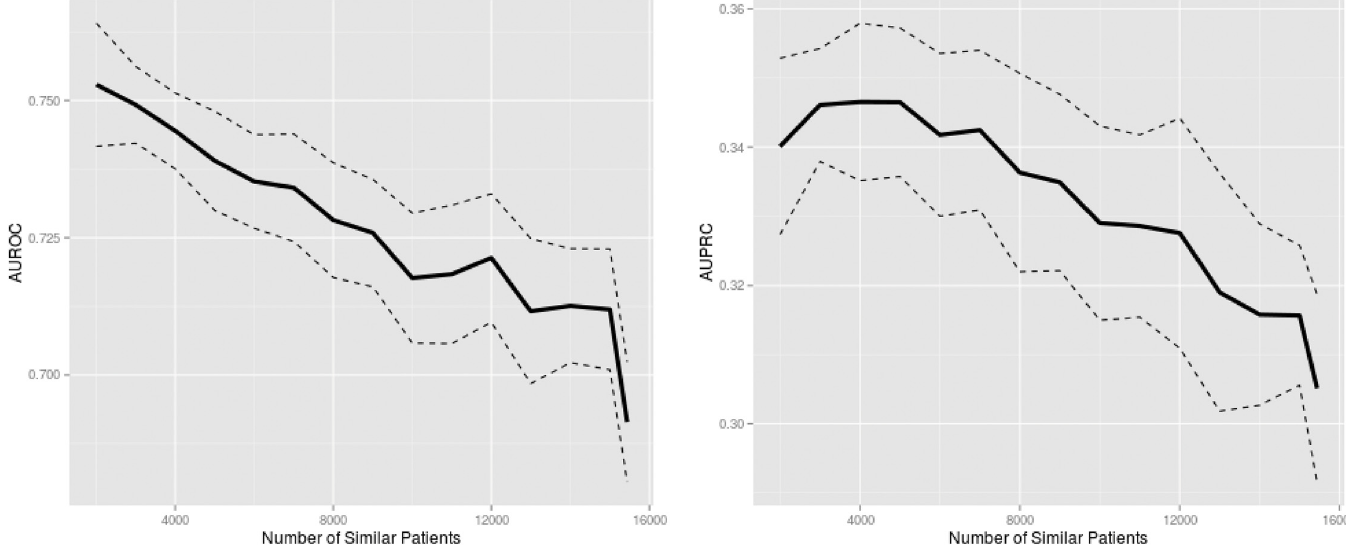
Fig 3. Mortality prediction performance of personalized decision trees trained on similar patient data. The solid and dashed lines are the mean and 95% confidence intervals, respectively, from 10-fold cross-validation. The maximum number of similar patients corresponds to all available training data. Predictive performance clearly improves as data from fewer but more similar patients are used for training. Identical outcome values in training data prohibited decreasing the number of similar patients further. AUROC: area under the receiver operating characteristic curve; AUPRC: area under the precision-recall curve.